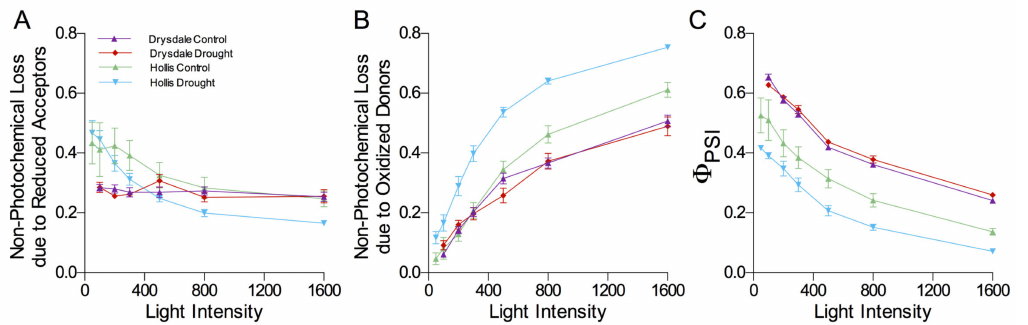
Figure 3. Photochemical analysis of photosystem I. ( A ) Y(NA), non-photochemical loss due to reduced acceptors. ( B ) Y(ND), non-photochemical loss due to oxidized donors. ( C ) Y(I), photoefficiency of photosystem I. The values represent the mean values ± SEM of 5 biological replicates for both control and drought conditions.